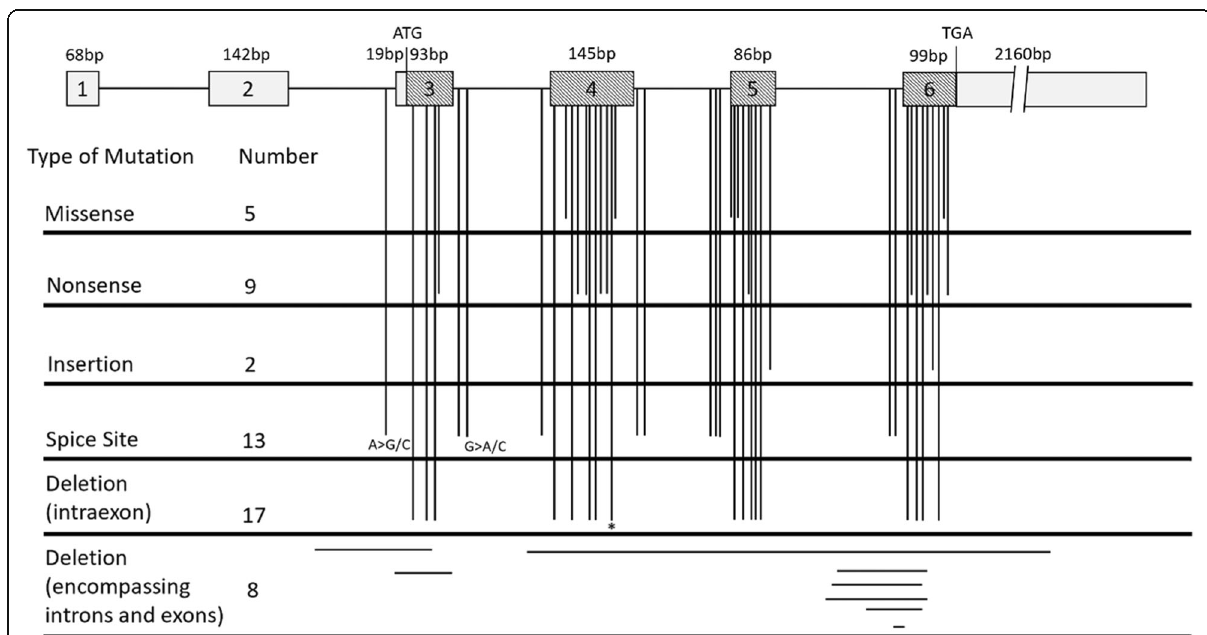
Fig. 4 The summary of identified variants in the TRAPPC2 gene illustrated by a schematic diagram. The human TRAPPC2 gene consists of six exons that span approximately 20 kb of genomic DNA. The 420 bp coding region (hatched boxes) is organized into four exons (exon 3 to exon 6). Non-coding exons (open boxes) consist of exons 1 and 2, the 5 ′ portion of exon 3, and the 3 ′ portion of exon 6. The translation Start (ATG) and Stop (TGA) codons in exon 3 and 6, respectively, are indicated. Introns are indicated by a line (not to scale). The locations of the 54 variants are indicated, including the variant identified in this study (denoted by the